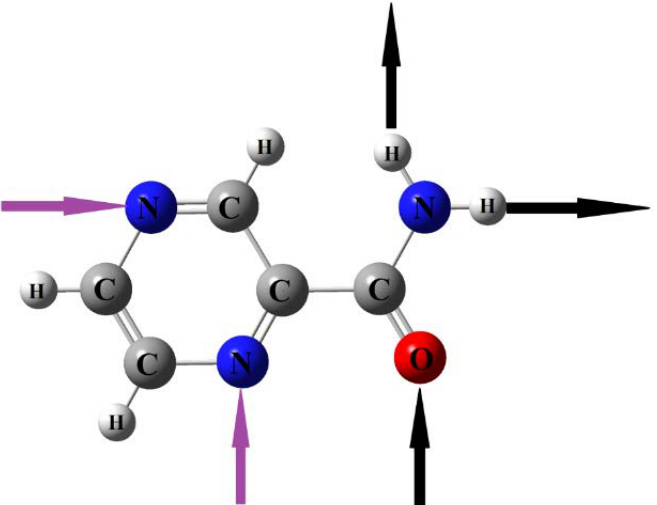
Figure 1. Molecular structure of pyrazinamide (PZA) (black arrows represent hydrogen bond donor positions and purple arrows indicate the possible positions of the hydrogen bond acceptor).